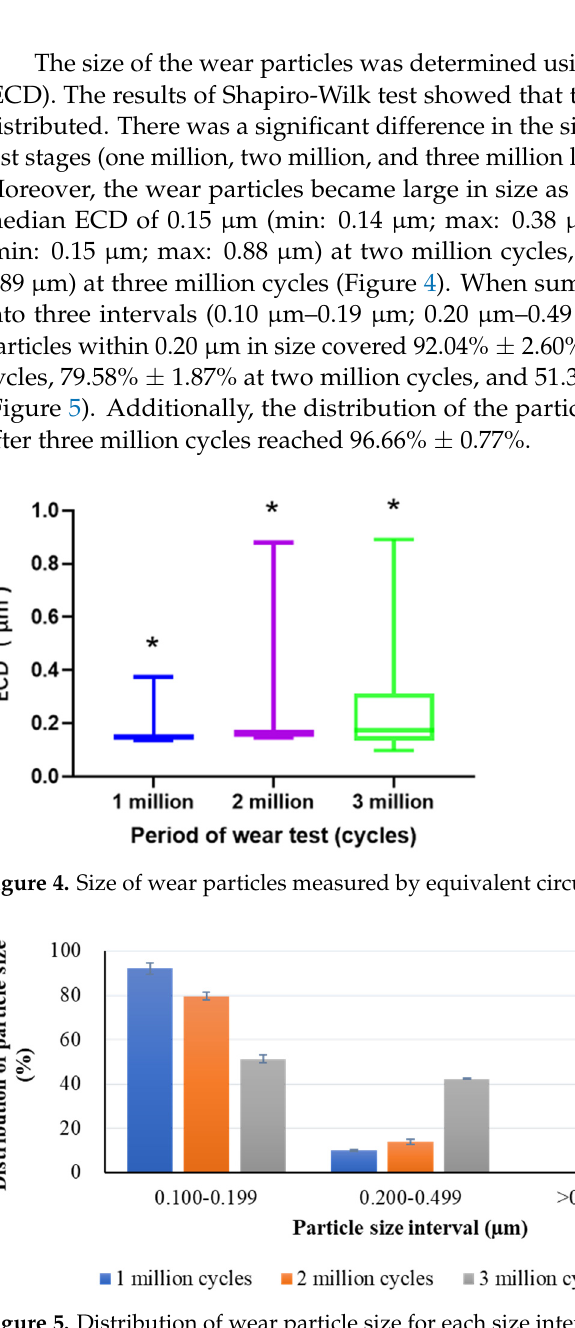
Figure 3. Content of wear particles generated after every one million cycles.